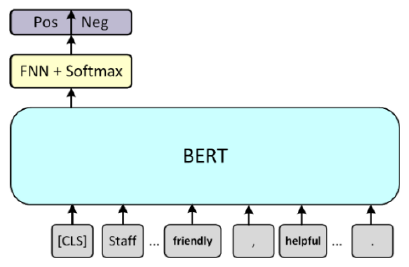
Figure 4. Sentiment classification model. Table 1. Examples of keywords and non-keywords for hotel comments.